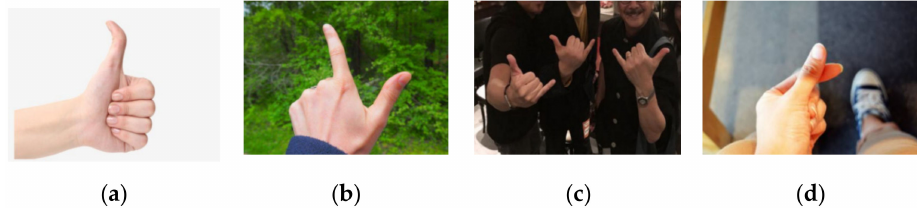
Figure 1. Gesture images with different backgrounds. ( a ) presents a gesture with a clean background and ( b – d ) present gestures with complex